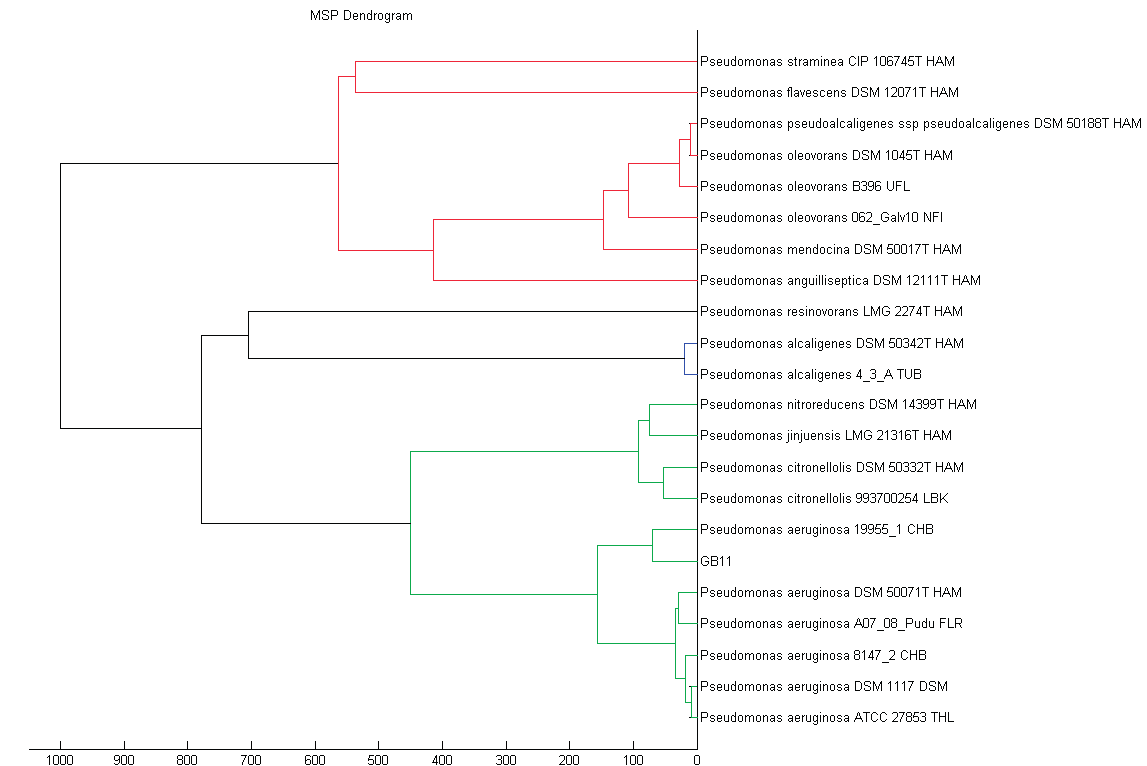
Figure 3. Bacterial identification of strain GB11 using MALDI-TOF. Dendogram shows the distance value assembled from the reference between species in the database using logarithmic